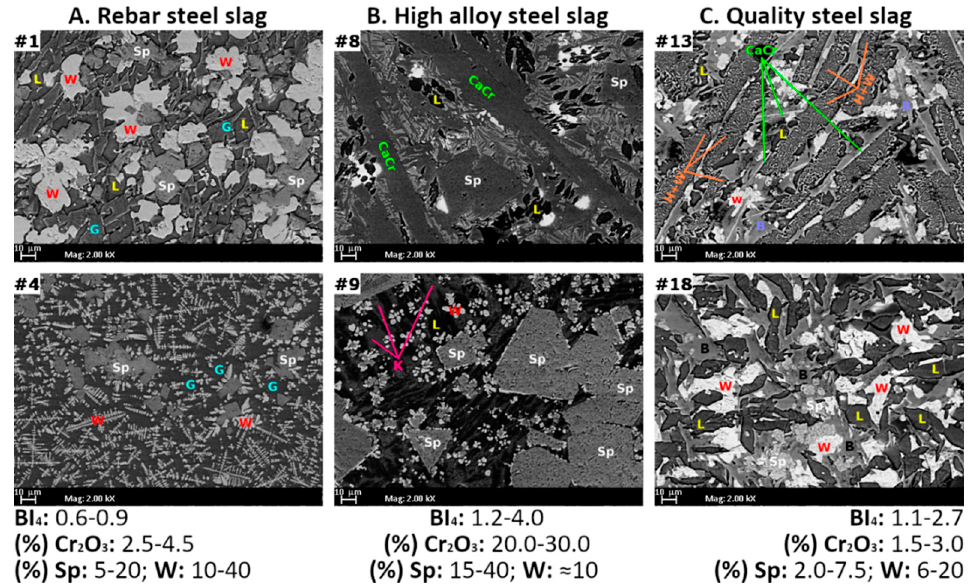
Figure 2. Example of SEM-BSE pictures of analyzed slag (samples 1, 4, 8, 9, 13, 18). B: brownmillerite; CaCr: Ca-chromite; G: gehlenite; H: hatrurite; K: kirschsteinite; L: larnite; Sp: spinel; W: wustite.